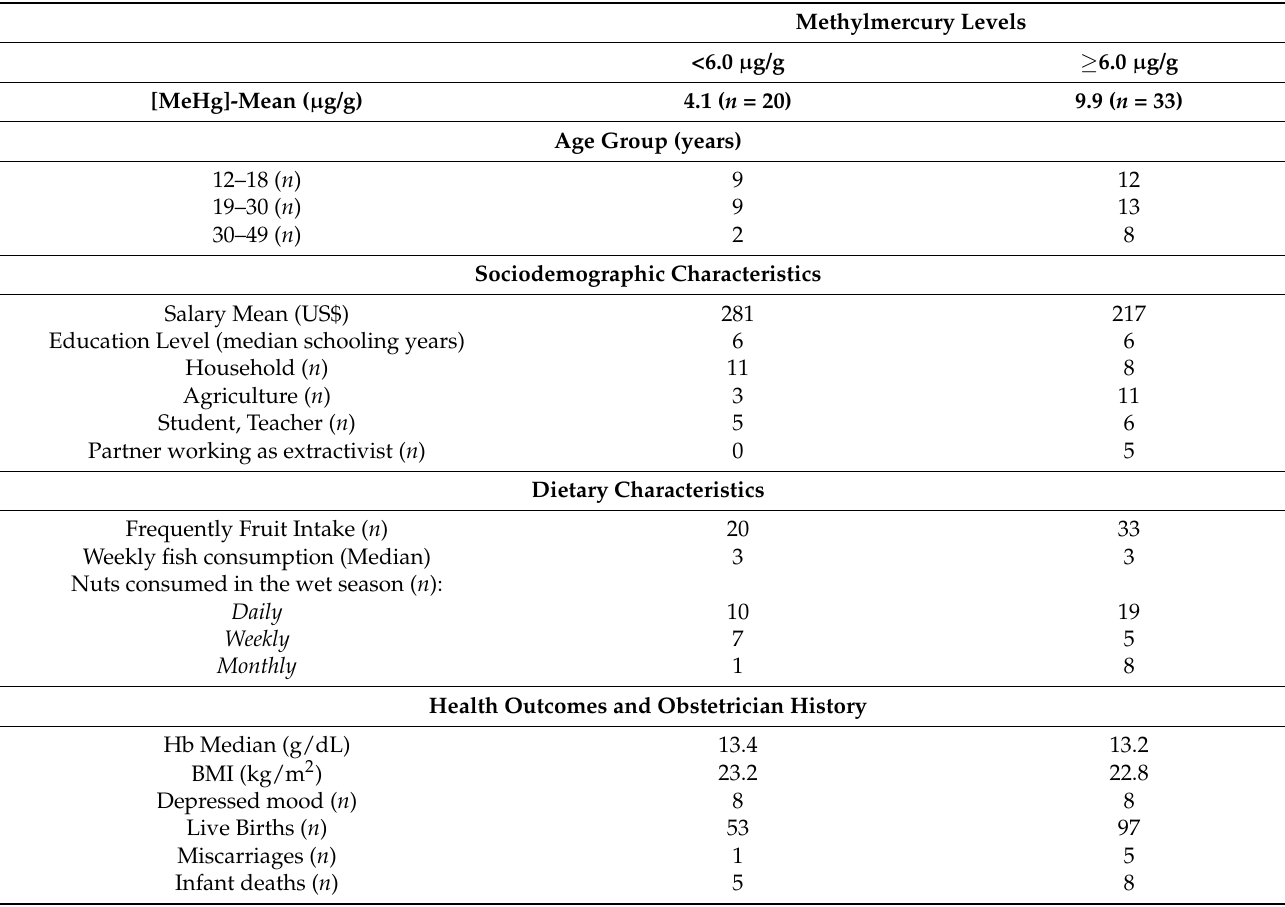
Table 2. Descriptive analysis of the woman of childbearing age, according to the methylmercury exposure levels (<6.0 µ g/g or ≥ 6.0 µ g/g), Sawr é Muybu Indigenous Land, Brazilian Amazon,